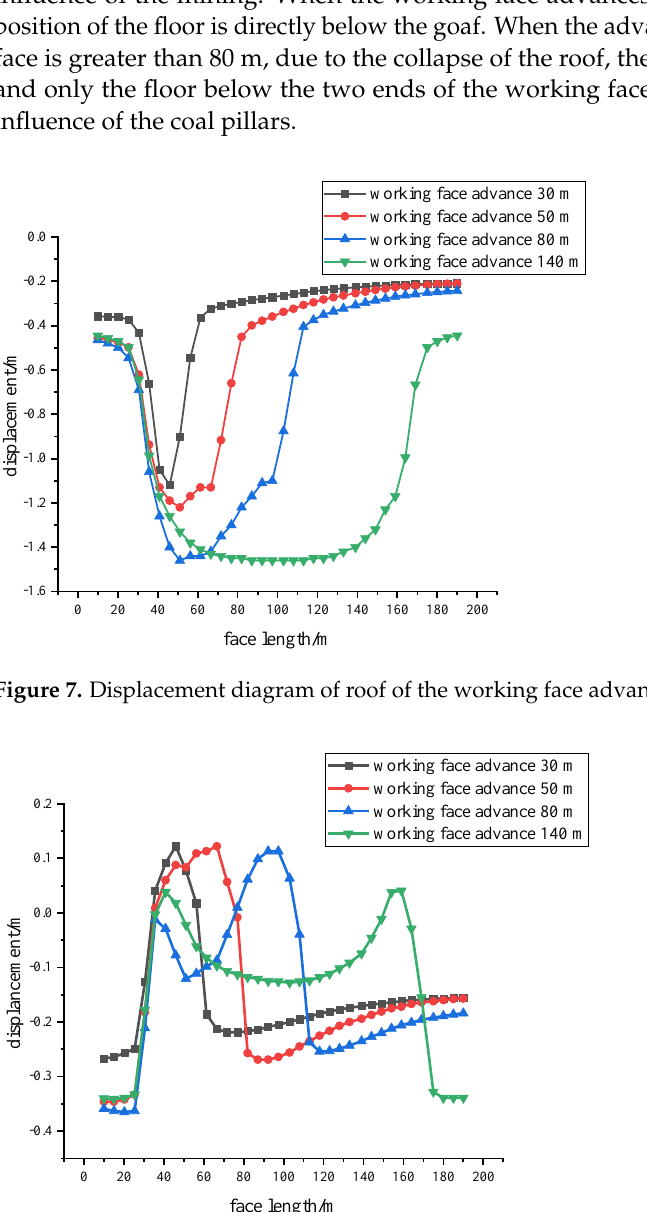
Figure 8. Displacement diagram of floor plate at different distances of working face propulsion.